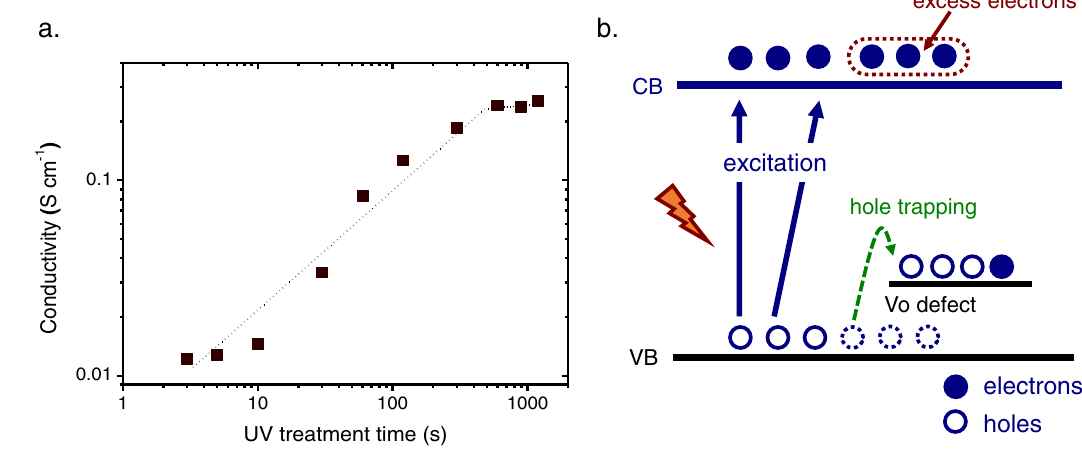
Fig. 1 | Mechanism of n-type conductivity in the UV-treated ZnO fi lm. a Conductivity of the sol-gel-grownZnO fi lm(annealedat160 o C, thickness: 25nm) plotted asa function of UVtreatment time (emissionwavelengthof the UV lamp is 365nmandthepowerofthelampis24W).BeforeUVtreatment,theconductivityis